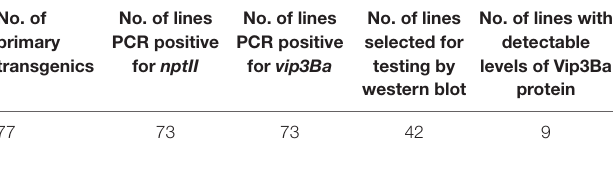
TABLE 5 | Summary of the molecular analysis of transgenic cowpea lines. No. of primary